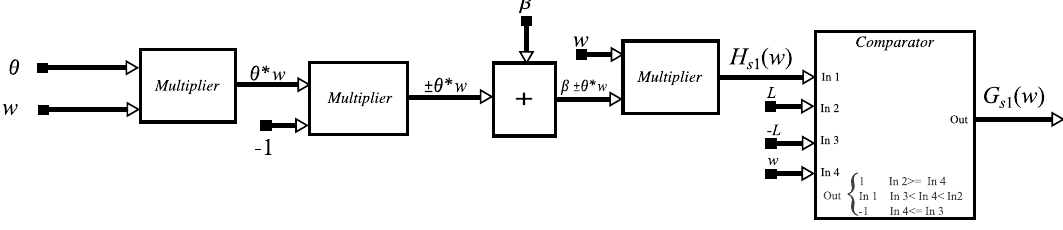
Figure 9. Block description of the hyperbolic tangent activation function using piecewise-linear (PWL)